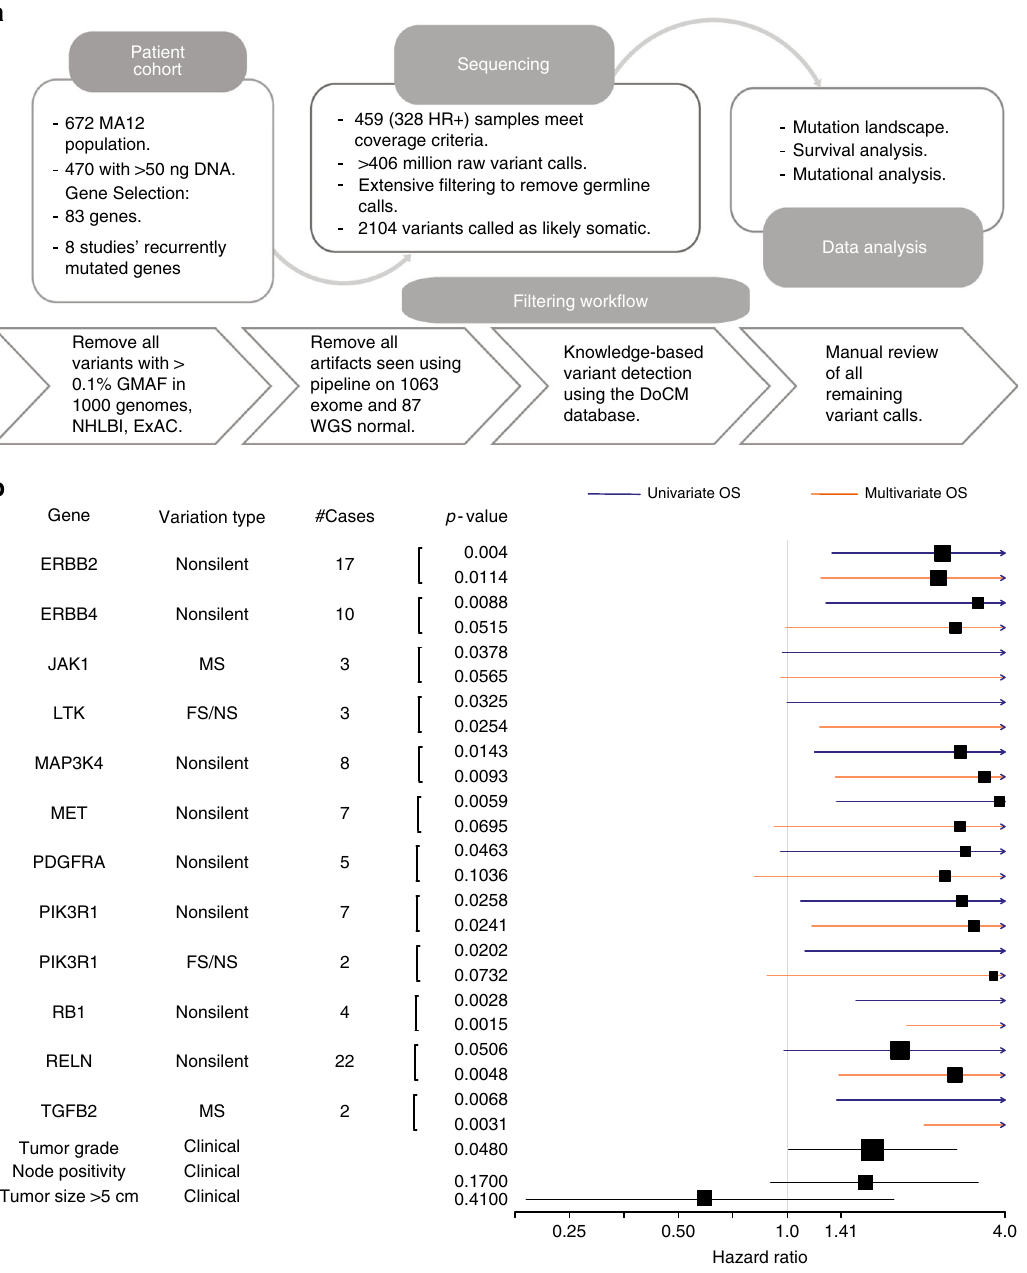
Fig. 4 Candidate discovery from MA12 cohort and prognosis evaluation. a DNA was extracted from tumor specimens and 470 samples with adequate yield were sequenced for 83 genes known to be recurrently mutated or breast cancer relevant. A total of 459 (328 HR + ) samples passed minimum quality checks and were sequenced to an average of 272.6× coverage. A total of 406 million variants from the reference genome were identi fi ed. Extensive fi ltering and manual review reduced this list to 2104 putatively somatic variants. Survival analysis was applied to non-silent and truncating gene mutation status versus overall survival. b Forest plot showing effect of mutation in candidate genes on overall survival (univariate — blue, multivariate — orange), along with the clinical factors used in the multivariate analysis (black), tumor grade, node positivity, and tumor size (>5 cm). The box size is relative to frequency of mutations in the analysis, with larger boxes representing higher incidence mutations. Note: a few boxes are not shown if their hazard ratios were greater than 4.0. Log-rank test was used to determine signi fi cance and Cox regression proportional hazards generated univariate hazard ratios. Multivariate Cox proportional-hazard model was used in the multivariate BRCA1/2 mutations observed (from 110/1128 patients across all 3 are less likely to be somatic given the general expectation of cohorts; 7 patients had two hits) 74 were observed at a VAF impure tumor samples and heterozygous mutations. Indeed, the greater than 40% and 31 were greater 60%. Additionally, of the 61 VAFs for BRCA1/2 and ATM non-silent mutations (mean = non-silent ATM mutations (from 58/1128 samples; 3 samples had 46.0%) were signi fi cantly higher than for other genes (mean = 2 hits) 39 had VAF greater than 40% and 18 had VAF greater 36.7%, p = 5.92e-09). Even when considered separately, the VAFs than 60 (Supplementary Data 9). Variants with VAFs this high for BRCA1 (mean = 46.6%), BRCA2 (mean = 43.8%), and ATM